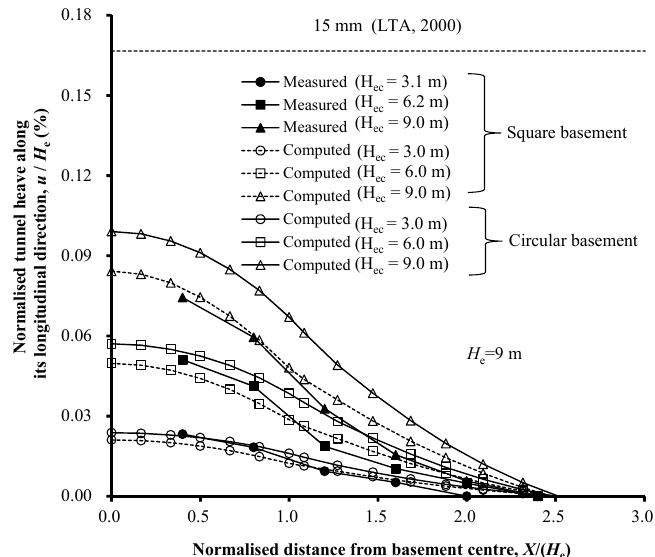
Figure 4. Measured and computed tunnel heave.